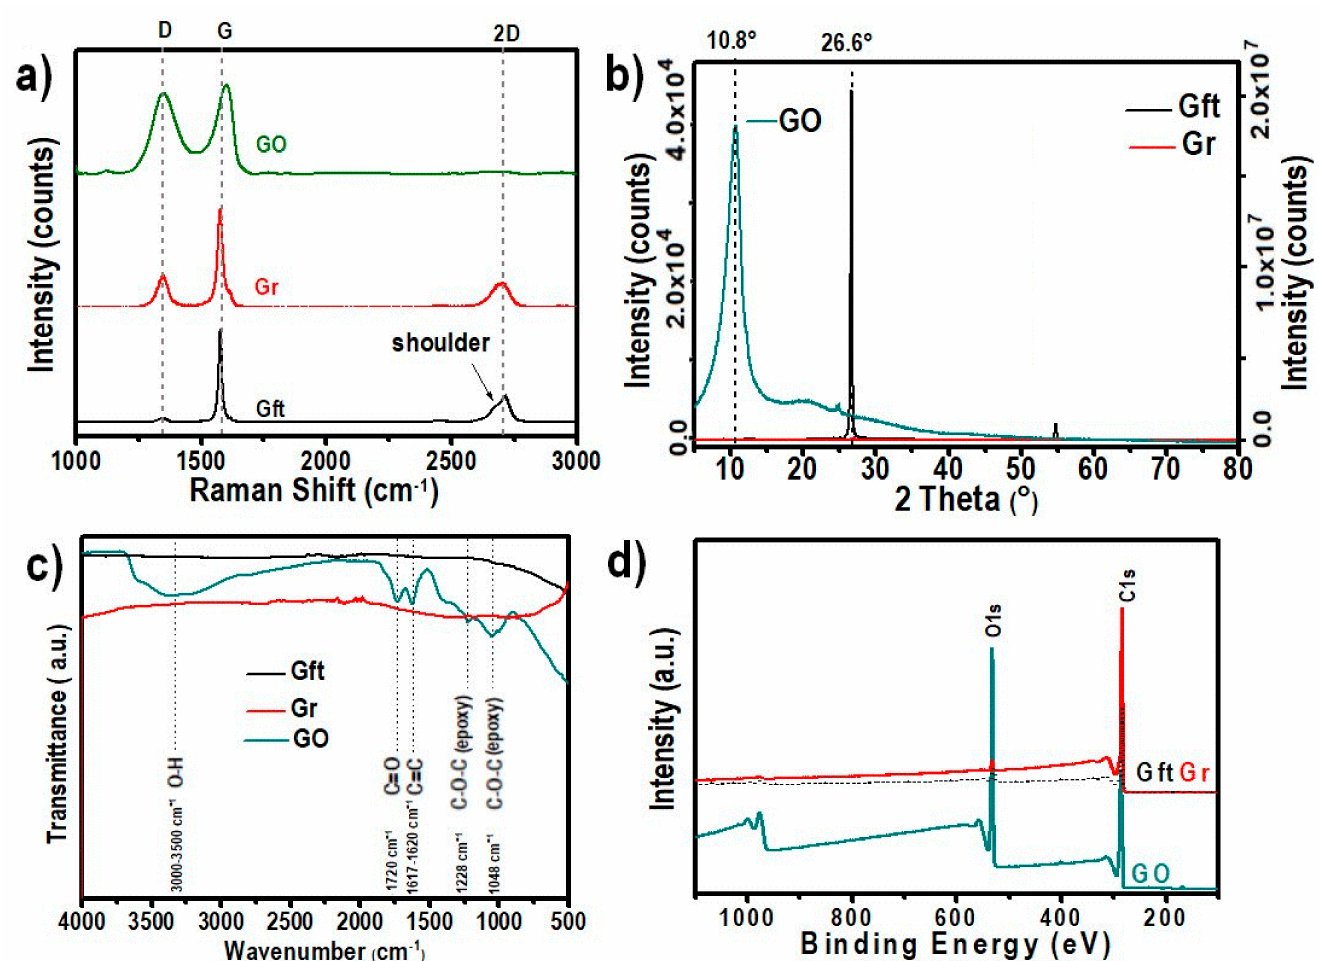
Figure 2. ( a ) Raman spectra, ( b ) XRD diffractograms with a right inset showing comparative intensity of Gr and Gft, ( c ) FTIR spectra and ( d ) XPS survey plots with an inset of atomic composition of parent GO, Gr and Gft